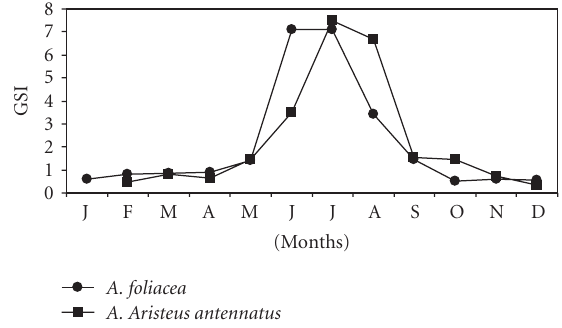
Figure 4: Temporal variation of gonadosomatic index (GSI), of Aristaeomorpha foliacea and Aristeus antennatus from the eastern Ionian